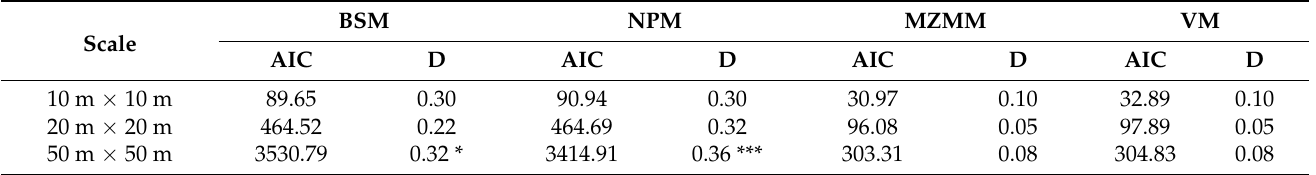
Figure 1. Species-abundance distributions (SADs) and model fitting for the evergreen and deciduous broad-leaved mixed forest. Graphs ( a – c ) represent rank-abundance plots and the fitting of the four models at increasing plant sampling spatial scales (m × m). Observed values are shown as open circles, and simulated values are shown as different colored curves. Among these, the solid red line represents the fitted distribution of the BSM, the dashed red line represents the fitted distribution of the NPM, the solid blue line represents the fitted distribution of the VM, and the dashed blue line represents the fitted distribution of the MZMM. Table 1. Goodness of fit tests of four models for the species abundance distributions in the evergreen and deciduous broad-leaved mixed forest at different sampling scales.